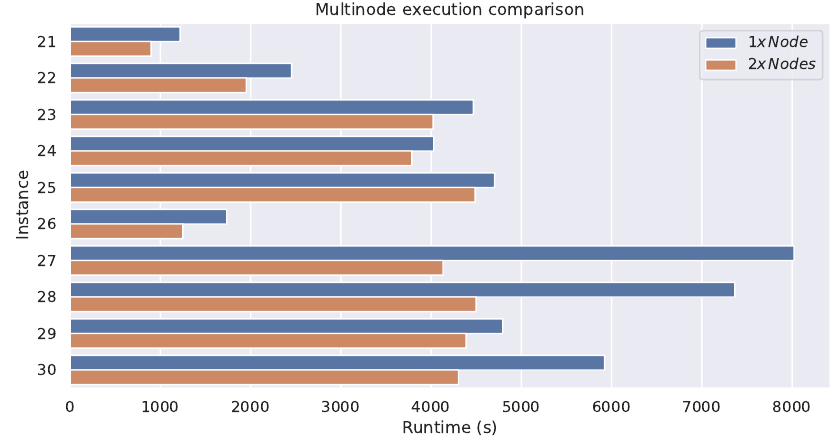
Figure 16. Time consumed by different execution approximations.